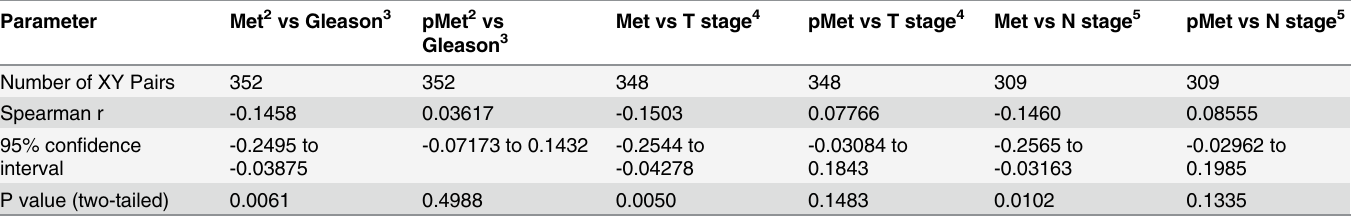
Table 3. Spearman correlation analysis of Met content, pMet content, Gleason score and clinical T and N stage for patient tumor samples 1 in the prostate adenocarcinoma (PRAD) TCGA Provisional dataset. Parameter